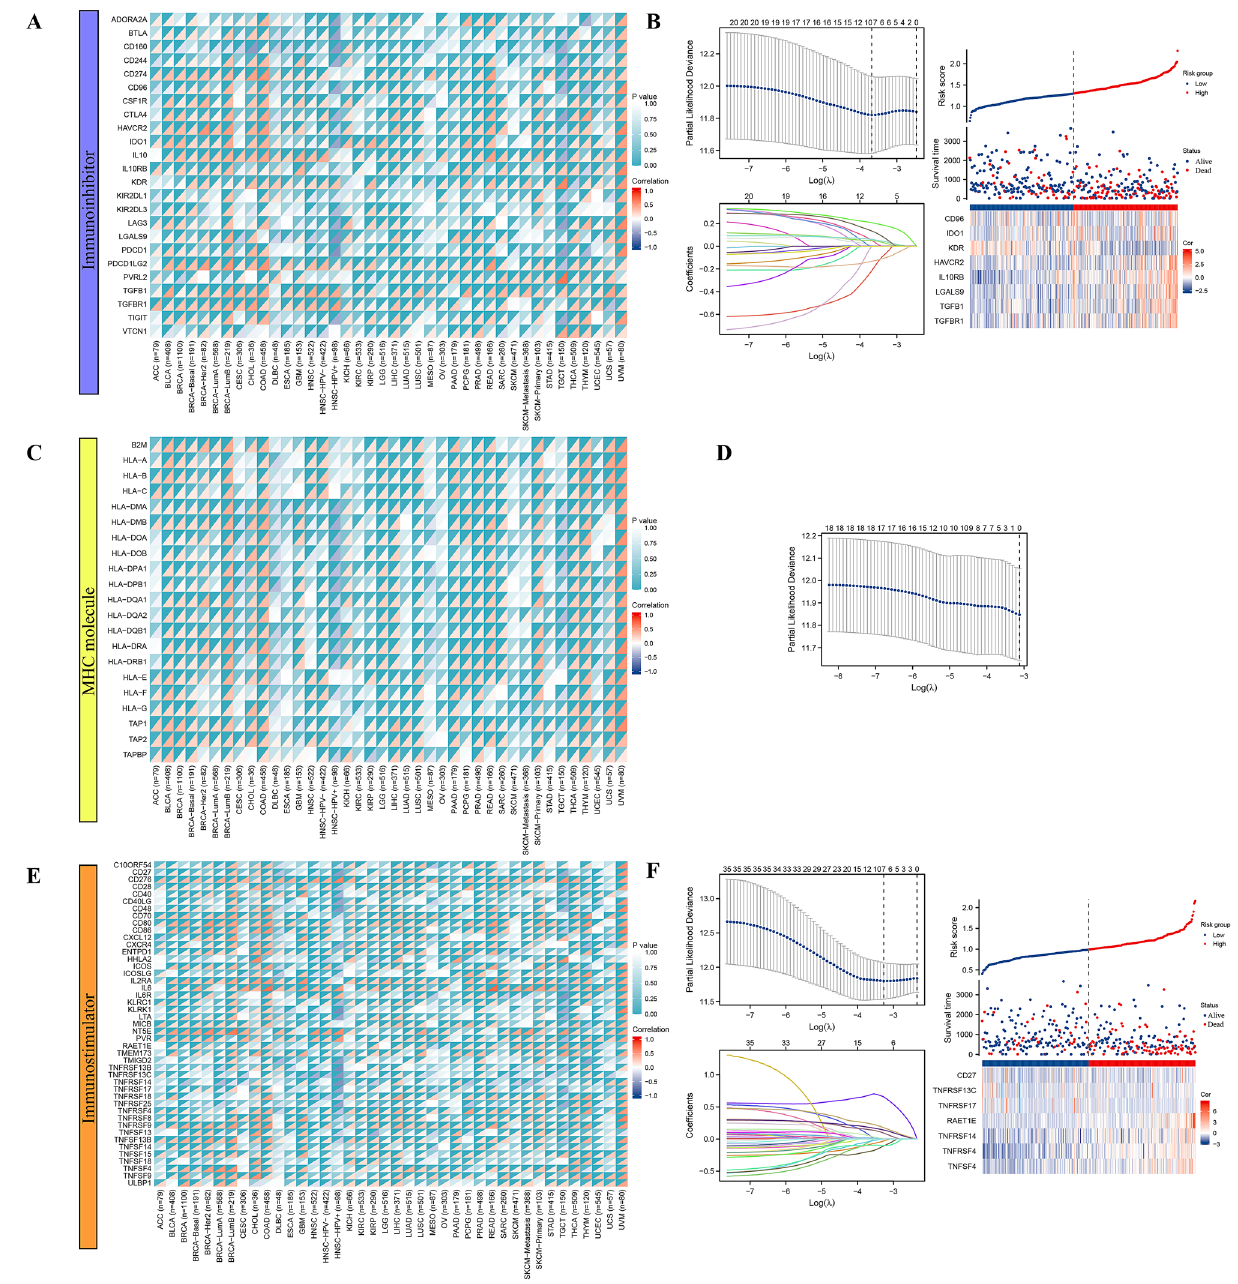
Figure 10. Analysis of correlation between MMP1 expression and multiple immune-related genes. ( A ) Immune-inhibitor genes—MMP1 expression heatmap; ( B ) Lasso analysis and risk factor prediction for immune suppressor genes; ( C ) MHC molecule genes—MMP1 expression correlation heatmap; ( D ) Lasso analysis for MHC molecules; ( E ) Immune-stimulator genes—MMP1 expression correlation heatmap; ( F ) Lasso analysis and risk factor prediction for immune-stimulating genes; MHC, major histocompatibility complex, * P < 0.05, ** P < 0.01, *** P <